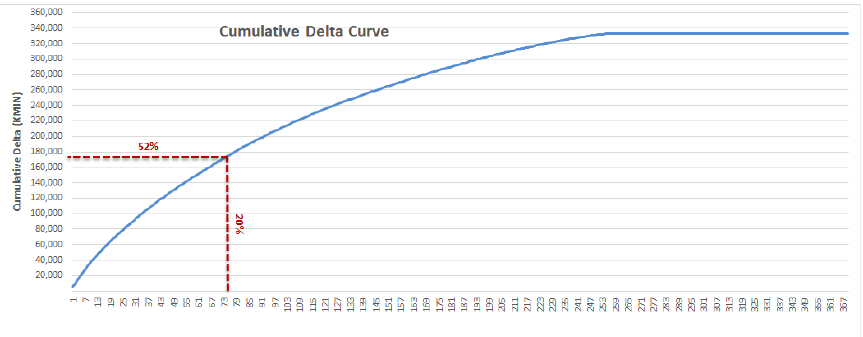
1 analysis. The blue area represents the gain of Figure 16. High concentration MV lines N − performances adopting the 4G procedure for DAS. The lines are ordered from the line with the highest mean impact to the lowest.